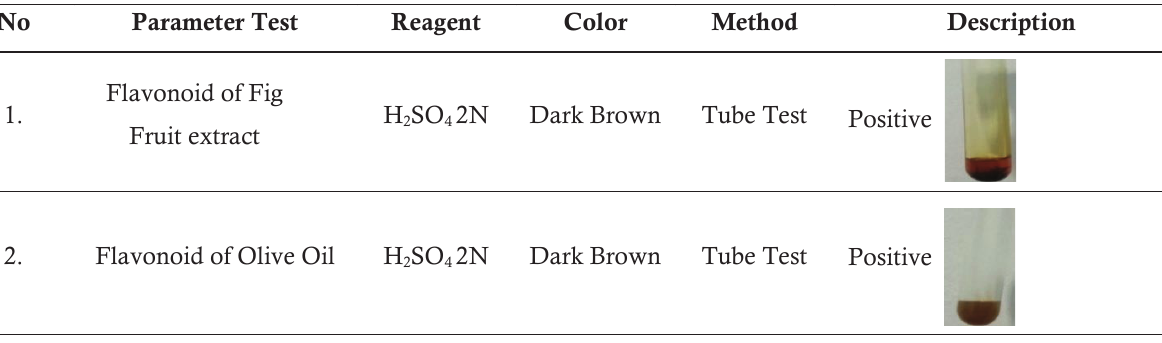
Table 2. Total Flavonoid Content of Fig Fruit Extract and Olive Oil Sample Fig Fruit Extract